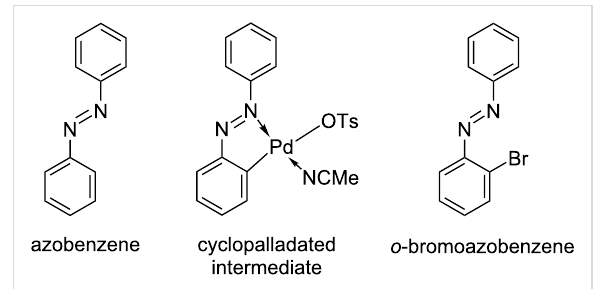
Figure 1: Molecular structures of the monomeric cyclopalladated inter- mediate and brominated product observed during the bromination of L1 under LAG conditions